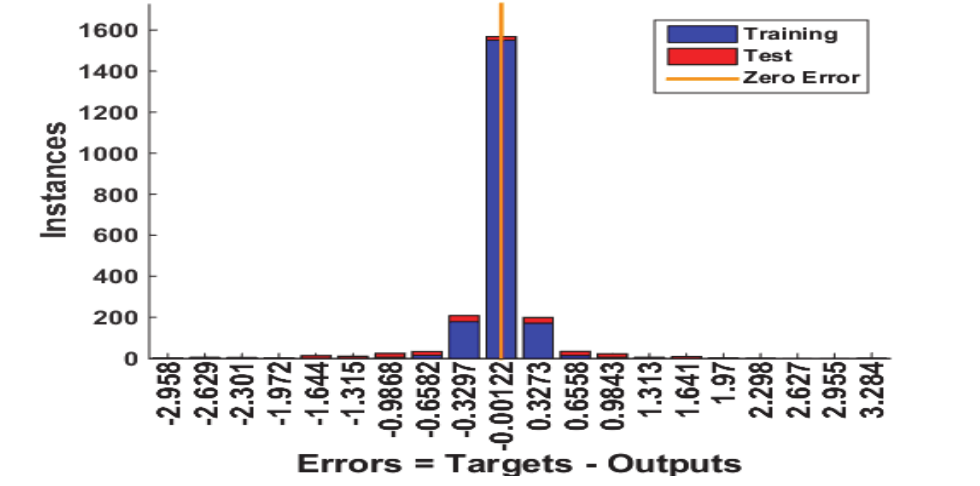
Fig. 4. Error distribution diagram